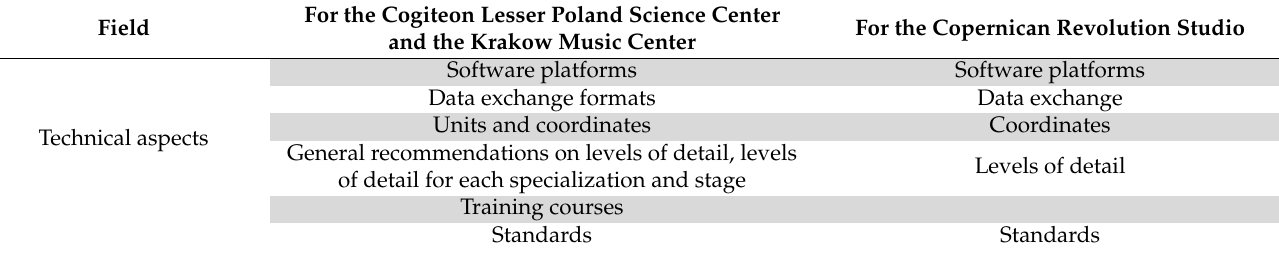
Table 2. Comparison of the fields and appendices of Employer’s Information Requirements (EIR) concerning BIM model preparation for the Cogiteon Lesser Poland Science Center, the Krakow Music Center and the Copernican Revolution Studio, Original work based on EIR for the LPSC, KMC and CRS.